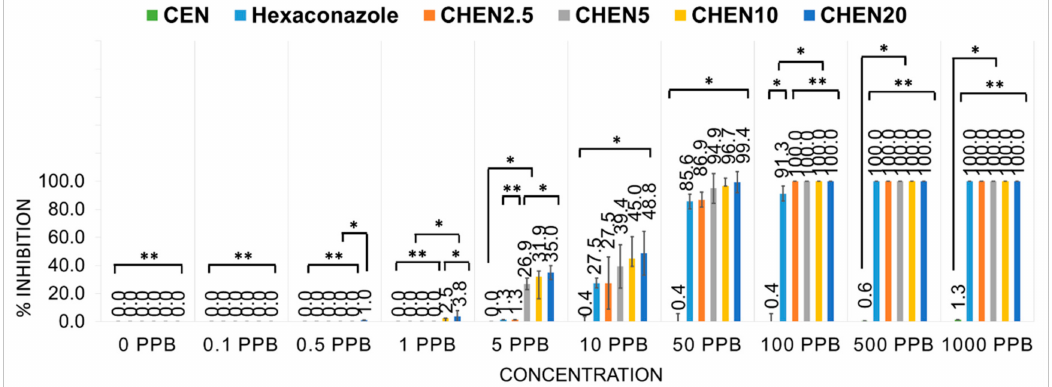
Figure 9. Percentage inhibition of radial growth of G. boninense against concentration, seven days after incubation at 28 ± 2 ◦ C; where * p < 0.01 (significant) and ** p > 0.5 (not significant); the error bars represent the standard deviation of the mean.